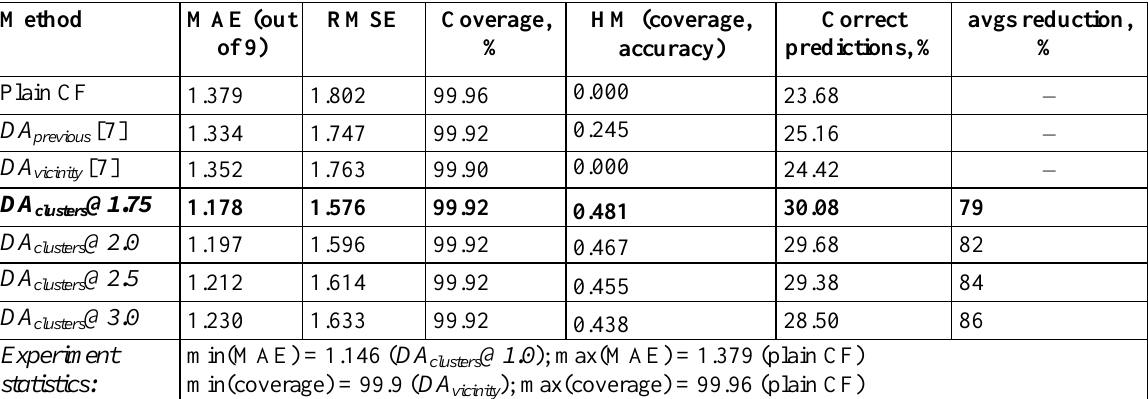
Table 7. MovieLens “Latest-20M, recommended for new research” dataset